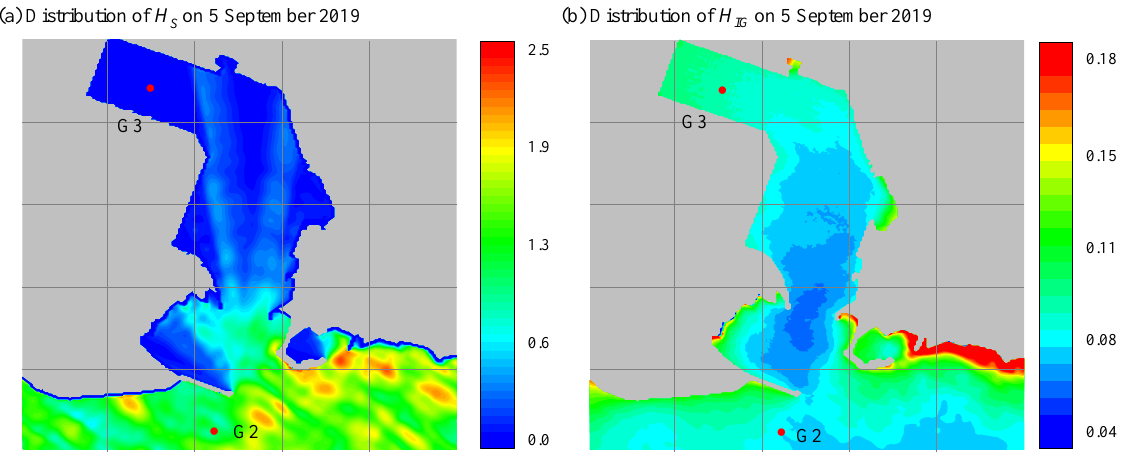
Figure 8. Modeled local significant wave height distributions: ( a ) short waves and ( b ) IG waves. The wave heights are the average for 5 September 2019.